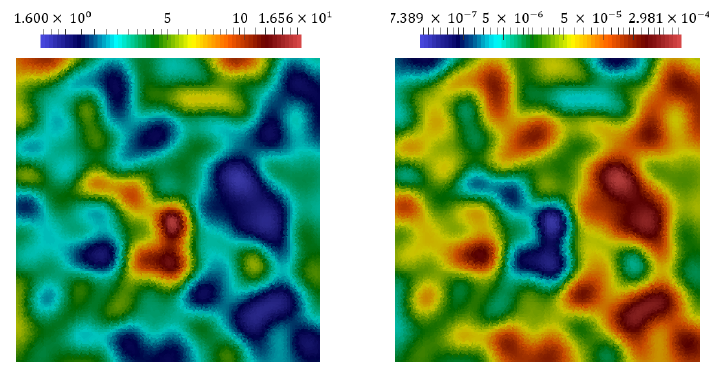
Figure 8. Elasticity coefficient E and heterogeneous permeability k